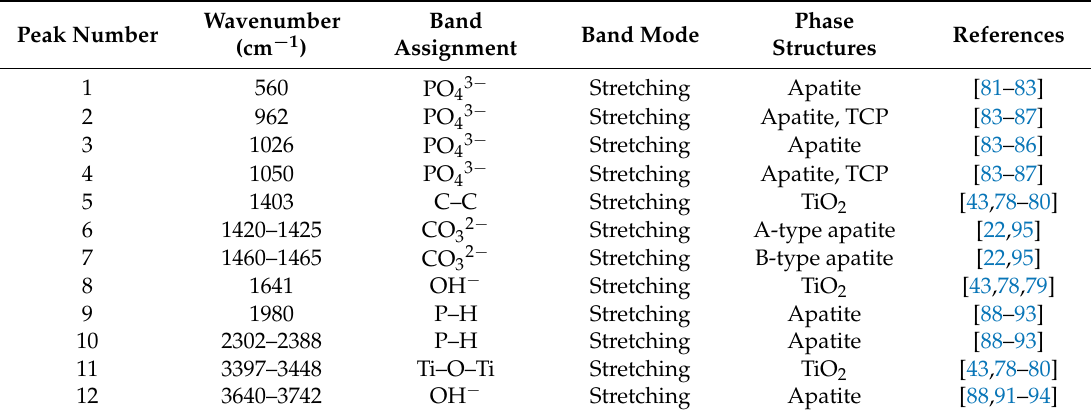
Table 5. ATR-FTIR spectrum analysis results for the MAO and Cu-based MAO coatings after immersion in